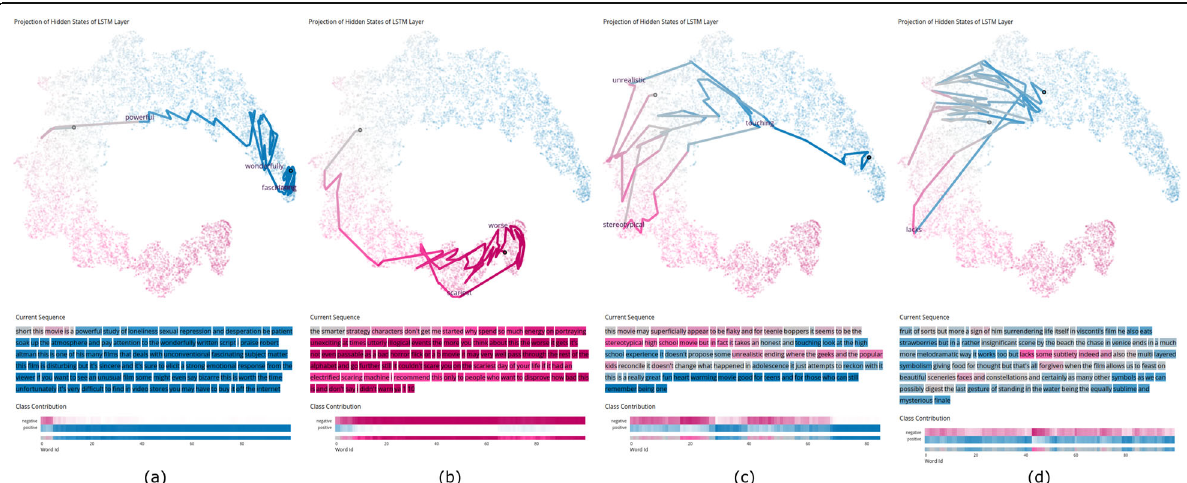
Fig. 4 Different examples of correctly classified sequences from the IMDB dataset. From left to right: ( a ): Typical example of a positively classified movie (blue). The first word that clearly classifies the sequence as positive is ‘ powerful ’ . Afterward, no word suggests that the movie might have been negatively rated. The words ‘ wonderfully ’ , ‘ strong ’ , and ‘ fascinating ’ result in particularly larger jumps in the hidden state space; ( b ): Typical example of a negatively classified sequence (pink). Right from the beginning, this review was classified negatively; ( c ): The input starts with several negative words (pink), making the model alternate between hidden states with high and low EPs. Toward the end of the review, the intent of the writer becomes clear and the model settles for a positive output (blue); ( d ): A positively classified movie with uncertainties. At the beginning and end, there are more indications of a positive rating (blue). However, most vocabulary feels more neutral than highly positive. In the middle, there is also a negative statement (pink). Underlying data source: IMDB as available in Keras